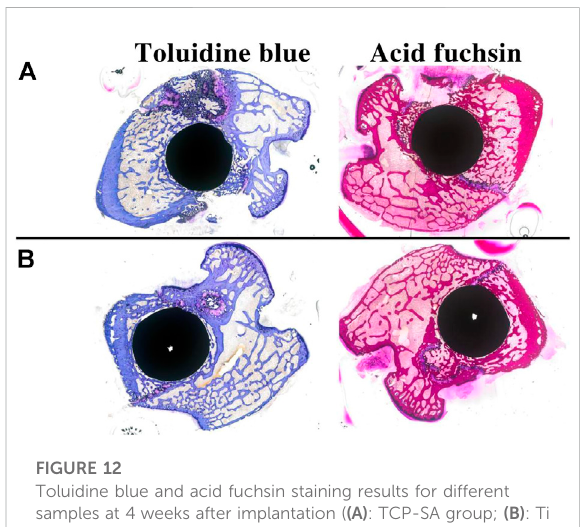
FIGURE 12 Toluidine blue and acid fuchsin staining results for different samples at 4 weeks after implantation ( (A) : TCP-SA group; (B) : Ti